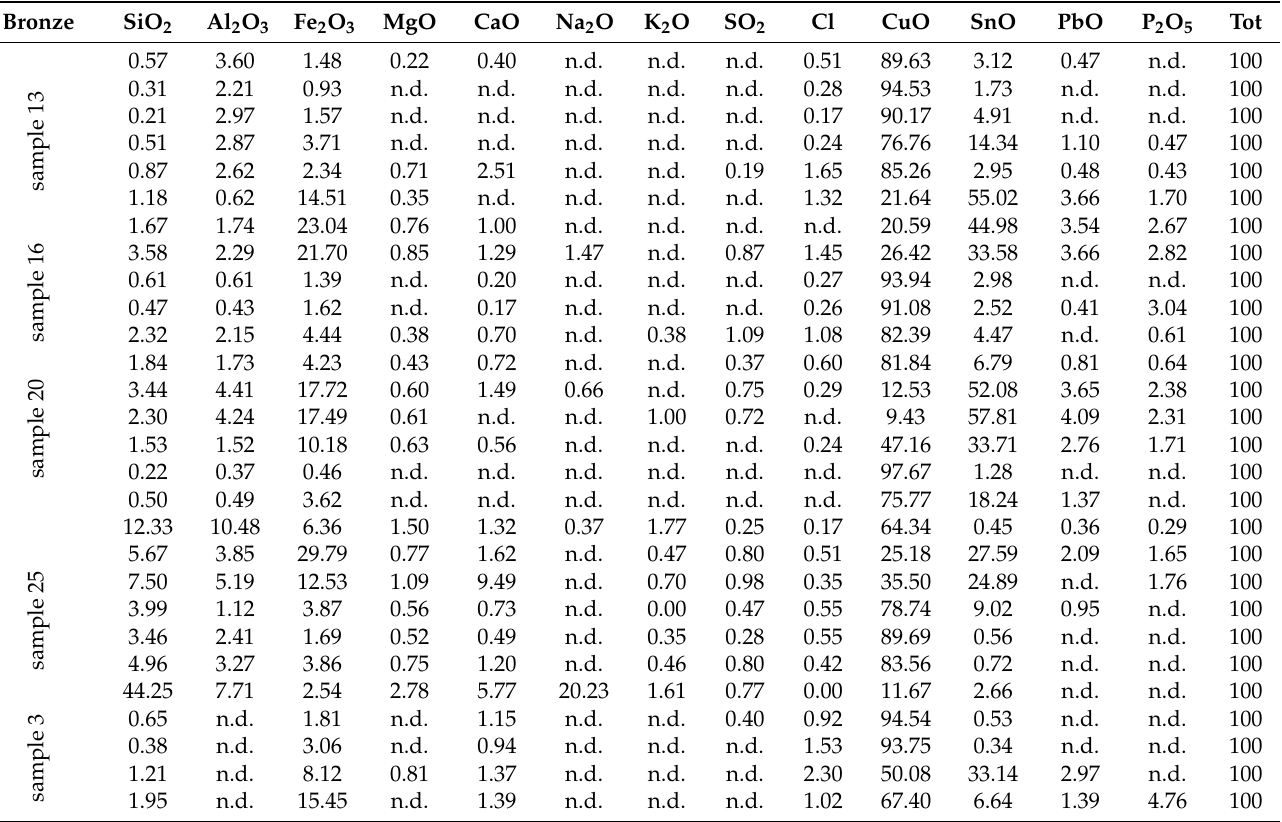
Table 3. SEM-EDS data analysis of all the bronze samples analyzed and expressed as oxides in percentage. The second column explains the specific AREA detected in the samples. Sample 3 was incorporated into the resin and sectioned. n.d. means not detected because below the detection